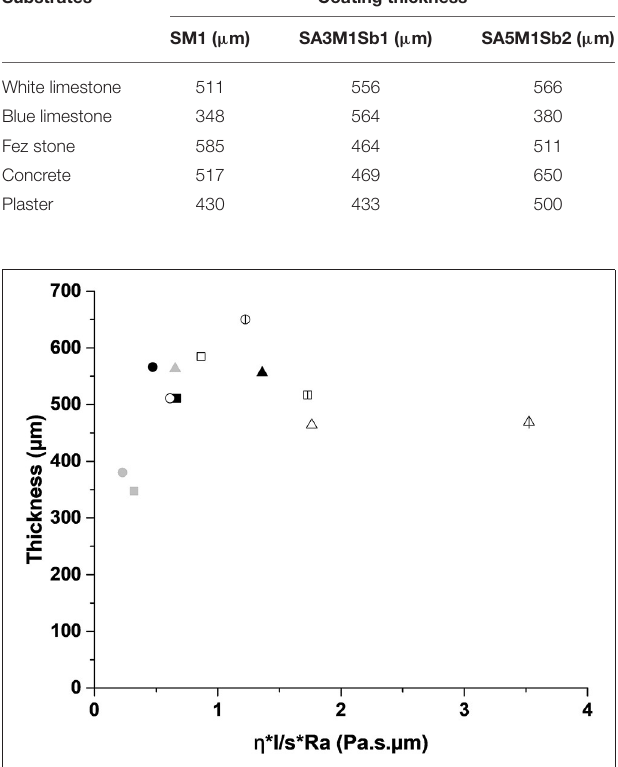
FIGURE 4 | Thickness of the coatings S1M1 ( (cid:4) ), S1A3M1Sbl ( N ), and S1A5 ( (cid:8) ) as function of ( η * l/s *Ra), with (black = white limestone), (gray = blue limestone), (white = Fez stone), and (hatched =